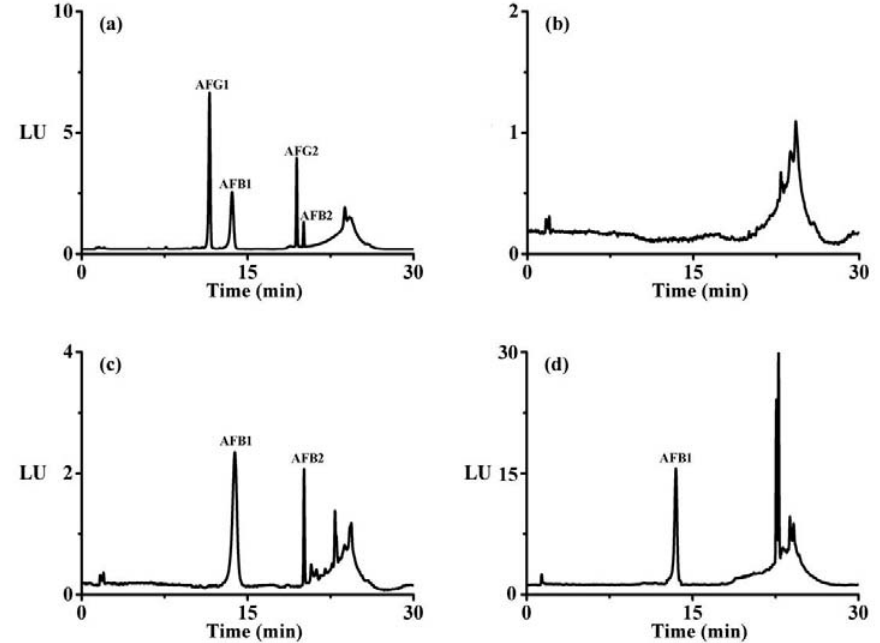
Figure 6. Chromatograms of aflatoxins in the peanut sample ( a , aflatoxins spiked at 1 μ g·kg − 1 each), the blank peanut sample ( b ), naturally contaminated samples of vegetable oil ( c ) and tea ( d